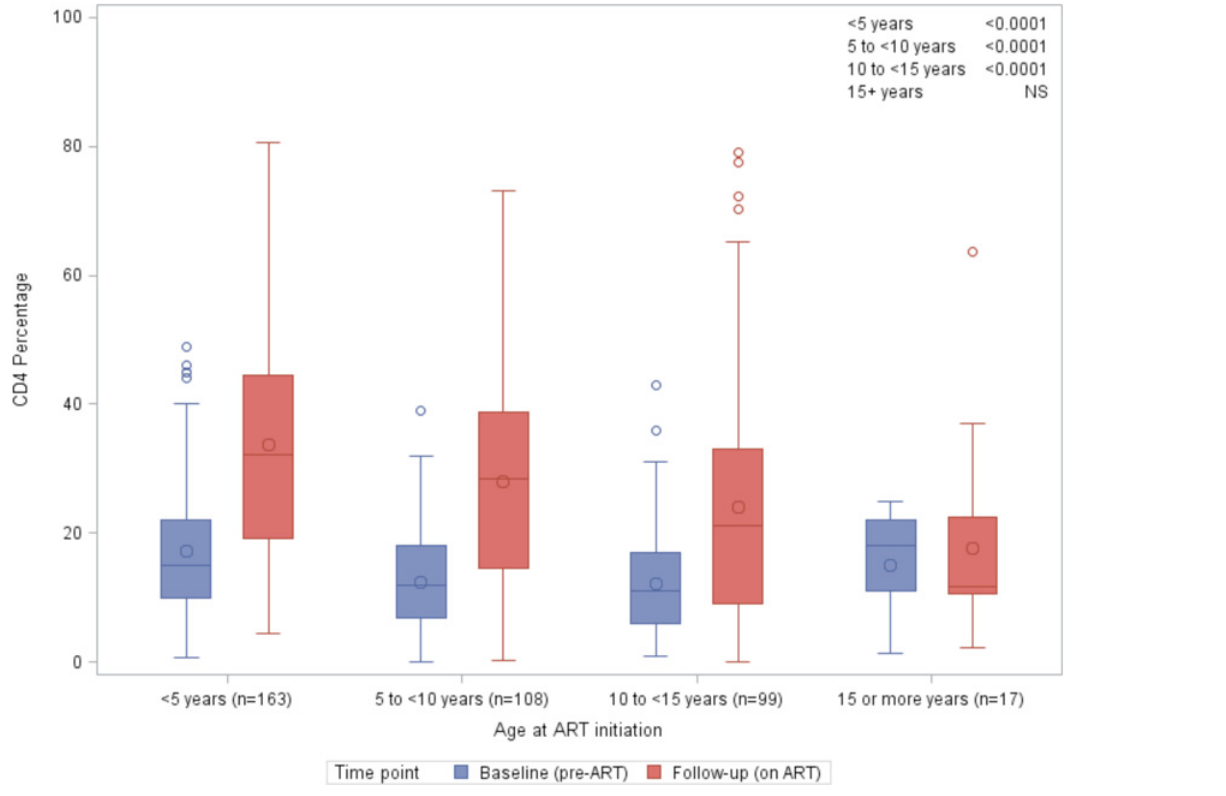
Fig 1. CD4 recovery on ART by age at ART initiation (n =